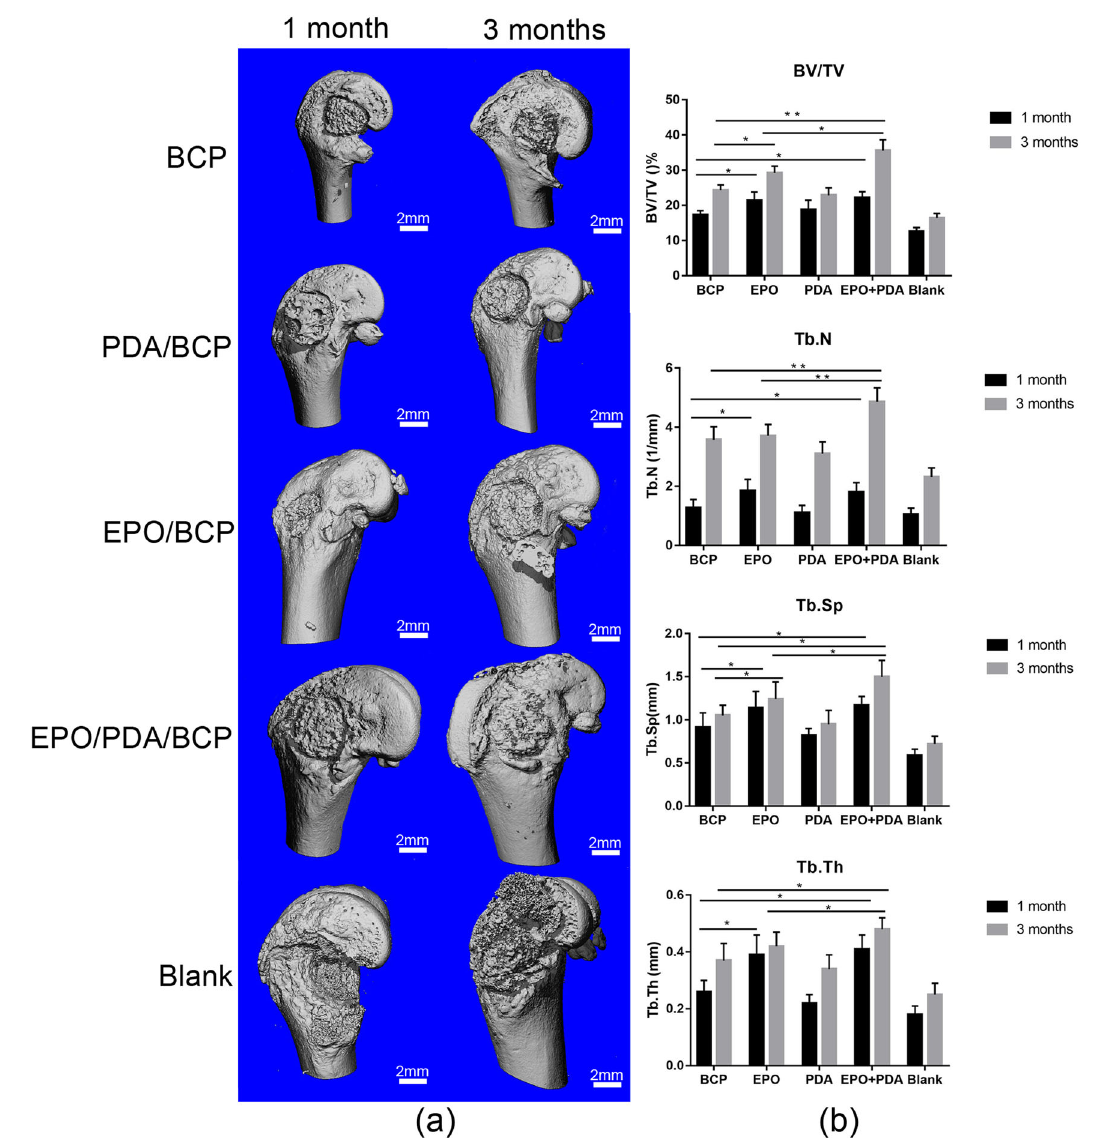
evaluation 1 and 3 months post operation shows the mean trabecular number (Tb.N), the ratio of bone tissue volume to total tissue